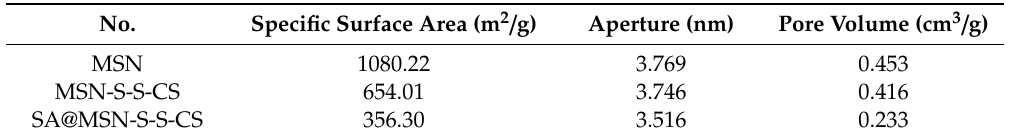
Table 1. Brunauer–Emmett–Teller surface area (BET) structure parameters of MSN-NH 2 , MSN-S-S-CS and